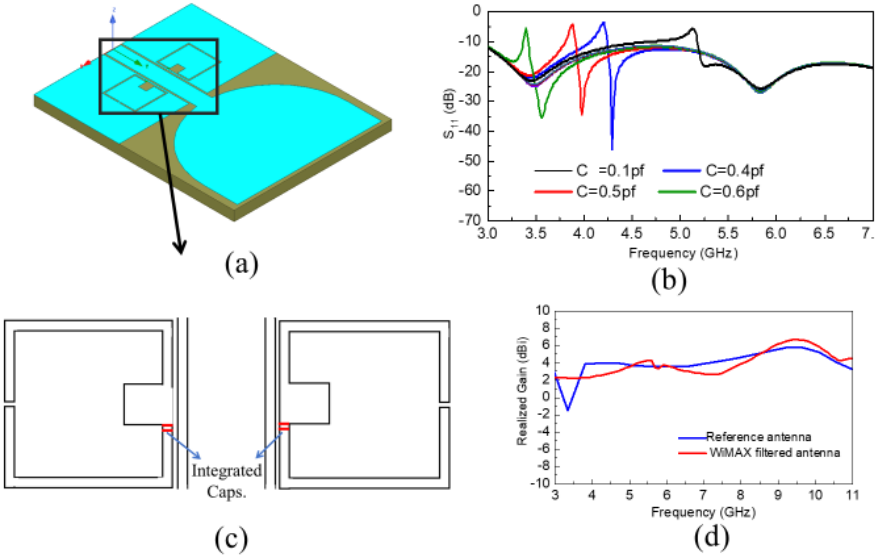
Figure 2. Switchable filter wide-band antenna; ( a ) Geometry of switchable filter wide-band antenna, ( b ) Reflection coefficient of switchable filter wide-band antenna at different capacitor values; ( c ) Zoomed in view of resonators with integrated capacitors; ( d ) Realized gain of reference and Worldwide Interoperability for Microwave Access (WiMAX) filtered wide-band antennas.